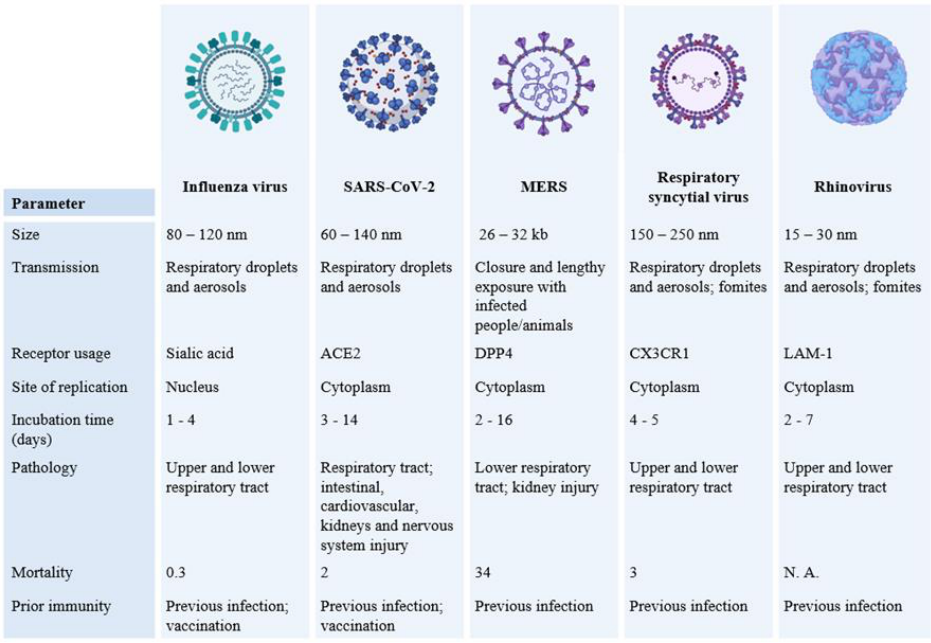
Figure 3. Microbiologic and epidemiologic comparisons between influenza virus, SARS ‒ CoV ‒ 2, Middle East Respiratory Syndrome (MERS), RSV and Rhinovirus [41,42]. Adapted from “Epidemiological Comparison of Respiratory Viral Infections”, by BioRender.com ( Accessed: 18/02/2022). Retrieved from [43].